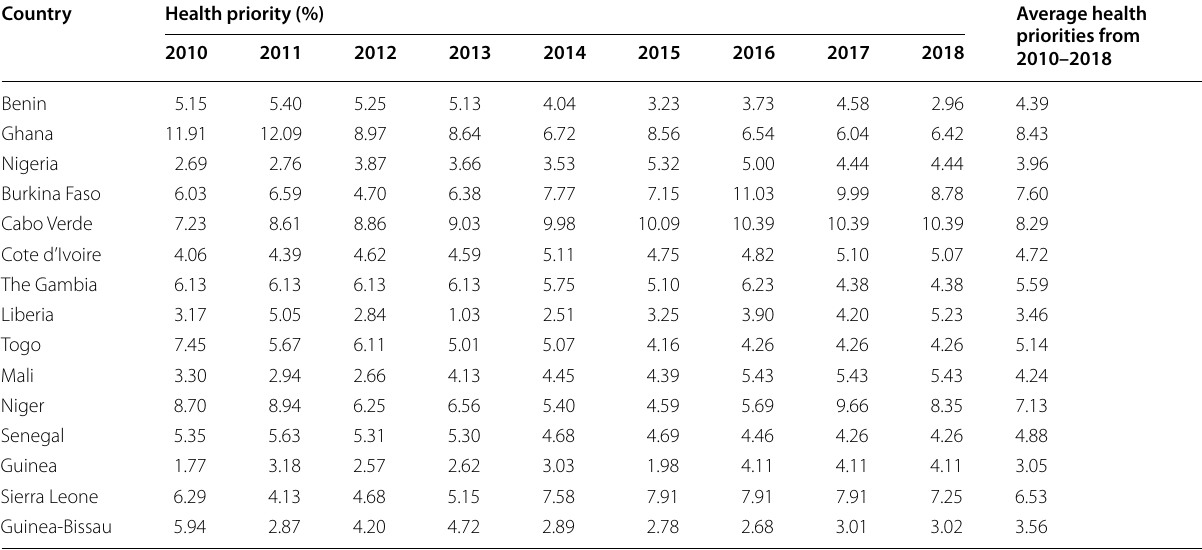
Source: Authors’ compilation from World Health Organization Global Health Expenditure Database